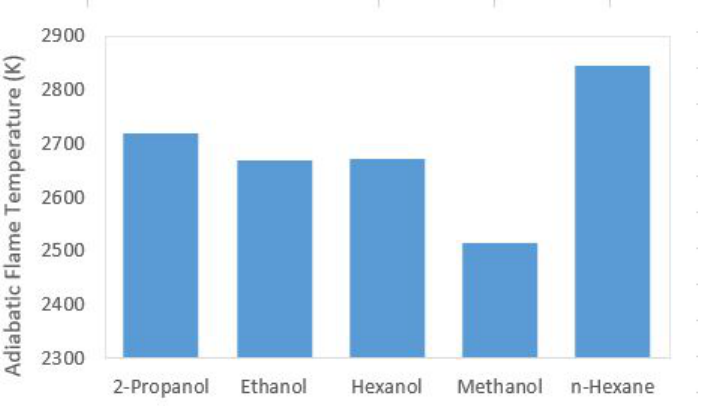
Figure 3. Adiabatic flame temperatures of a stoichiometric mixture of hydrogen peroxide and various catalyst solvents.